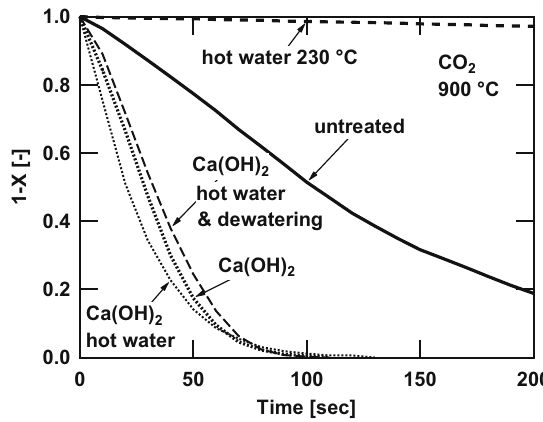
Figure 11: CO 2 gasi fi cation pro fi les at 900°C for the Ca - loaded co ff ee grounds ’ chars after the combined